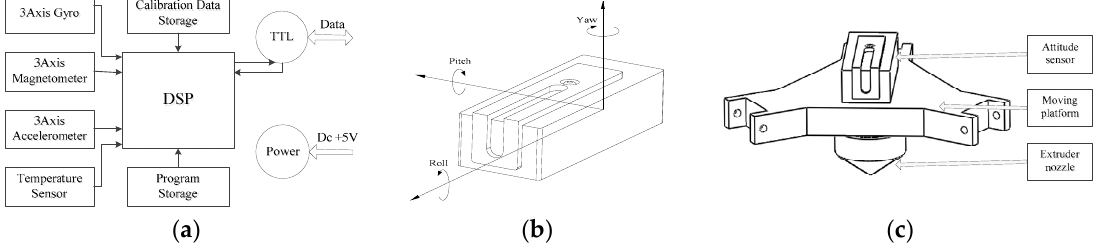
Figure 4. Attitude modelling theory: ( a ) the basic structure of the attitude sensor, ( b ) the reference frame and attitude angles, and ( c ) the schematic of the sensor installation.